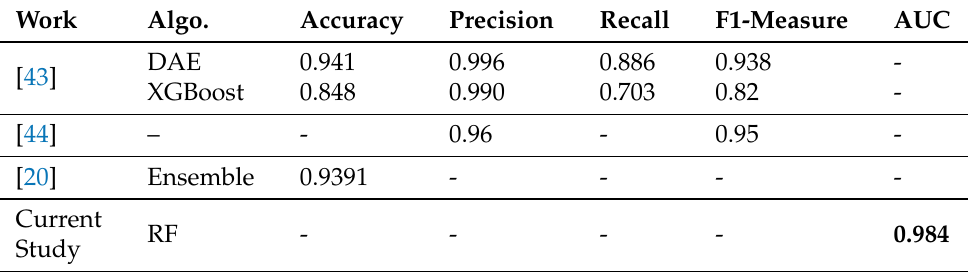
Table 9. Comparison with previous works on FDIA detection for the power system